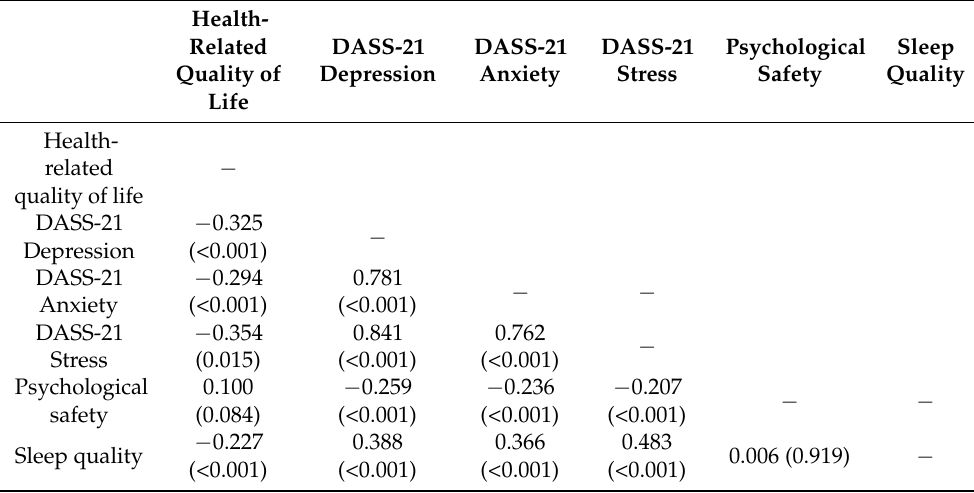
Table 3. Correlations among DASS-21, psychological safety, sleep quality, and health-related quality of life ( N =